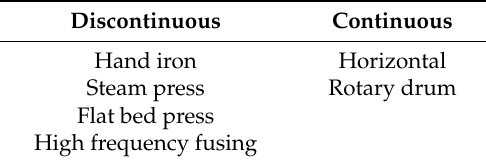
Table 3. Types of fusing systems